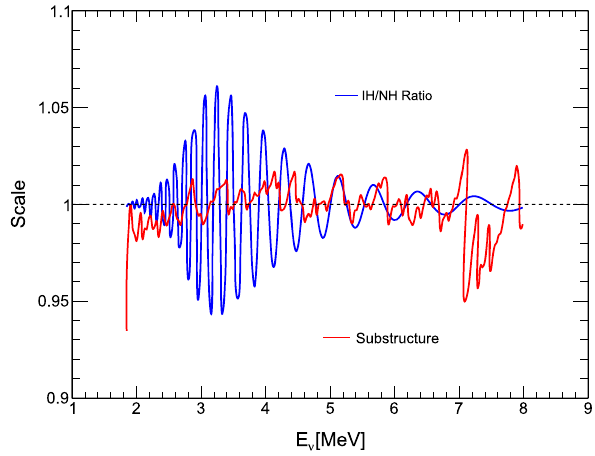
Fig. 3 Comparison of our estimated scale of fine structure (red) with the ratio between IH and NH (blue). The IH and NH spectra are shown in Fig. 1, which are generated based on the Daya Bay measured (un- oscillated)